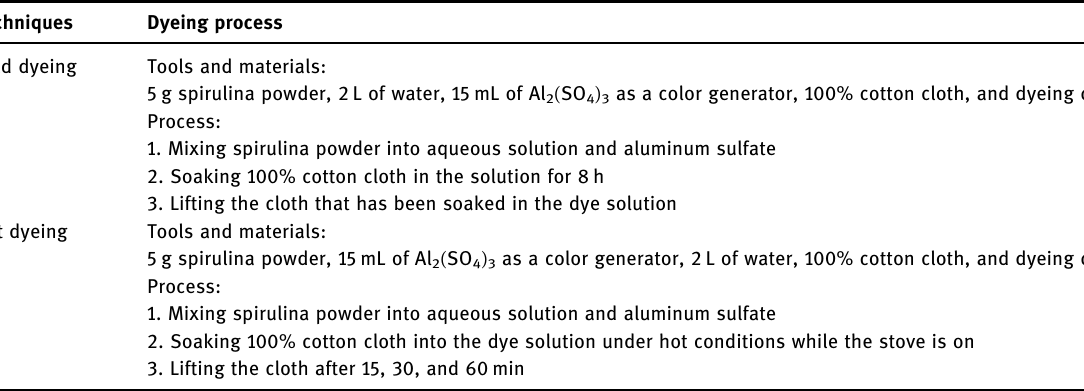
Table 1: Experimental variables of cold and hot dyeing on fabrics using Spirulina platensis powder Techniques Dyeing